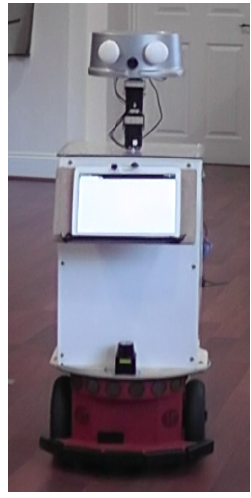
Figure 4: Sunflower robot.